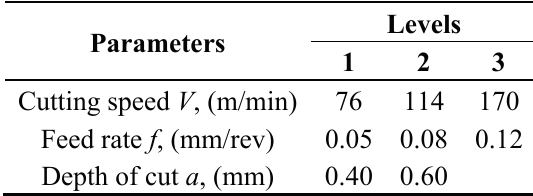
Table 4. Machining parameters and their